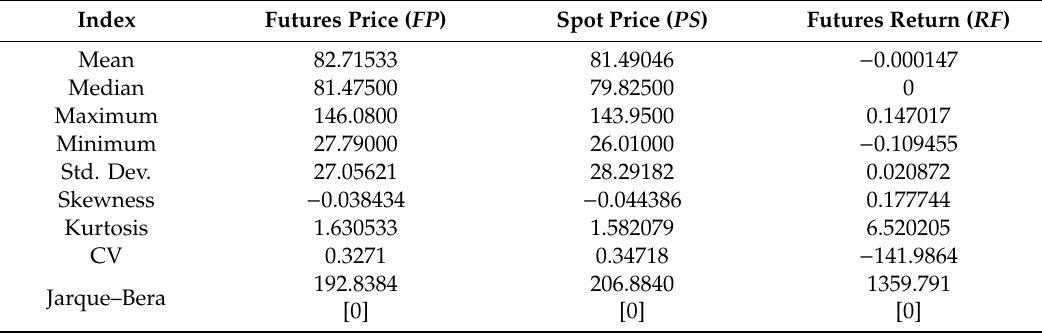
Table 2. Basic statistical characteristics of Brent oil futures price, spot price and futures return.